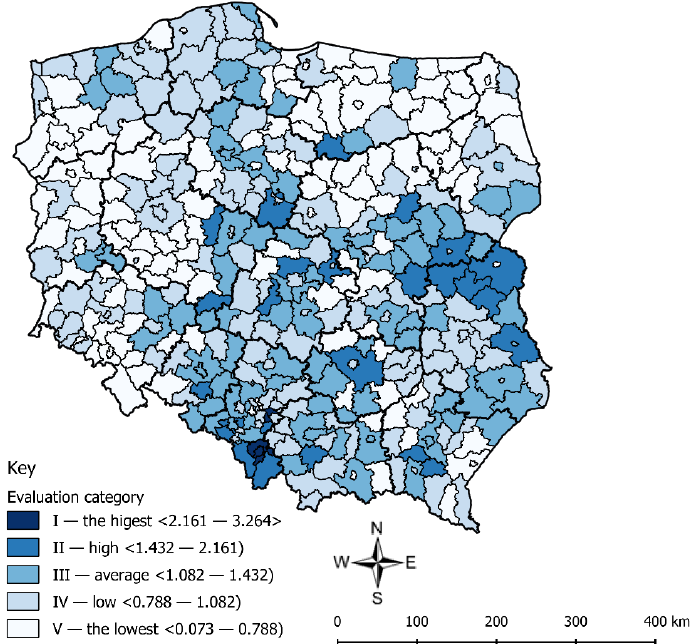
Figure 4. The ranges of the categories of the correctness of waste management for selected waste in comparison with all municipal waste in counties in Poland. Source: own elaboration. Table 1. The set of the concentration coefficients ( CC ) for the analyzed selected waste fractions.